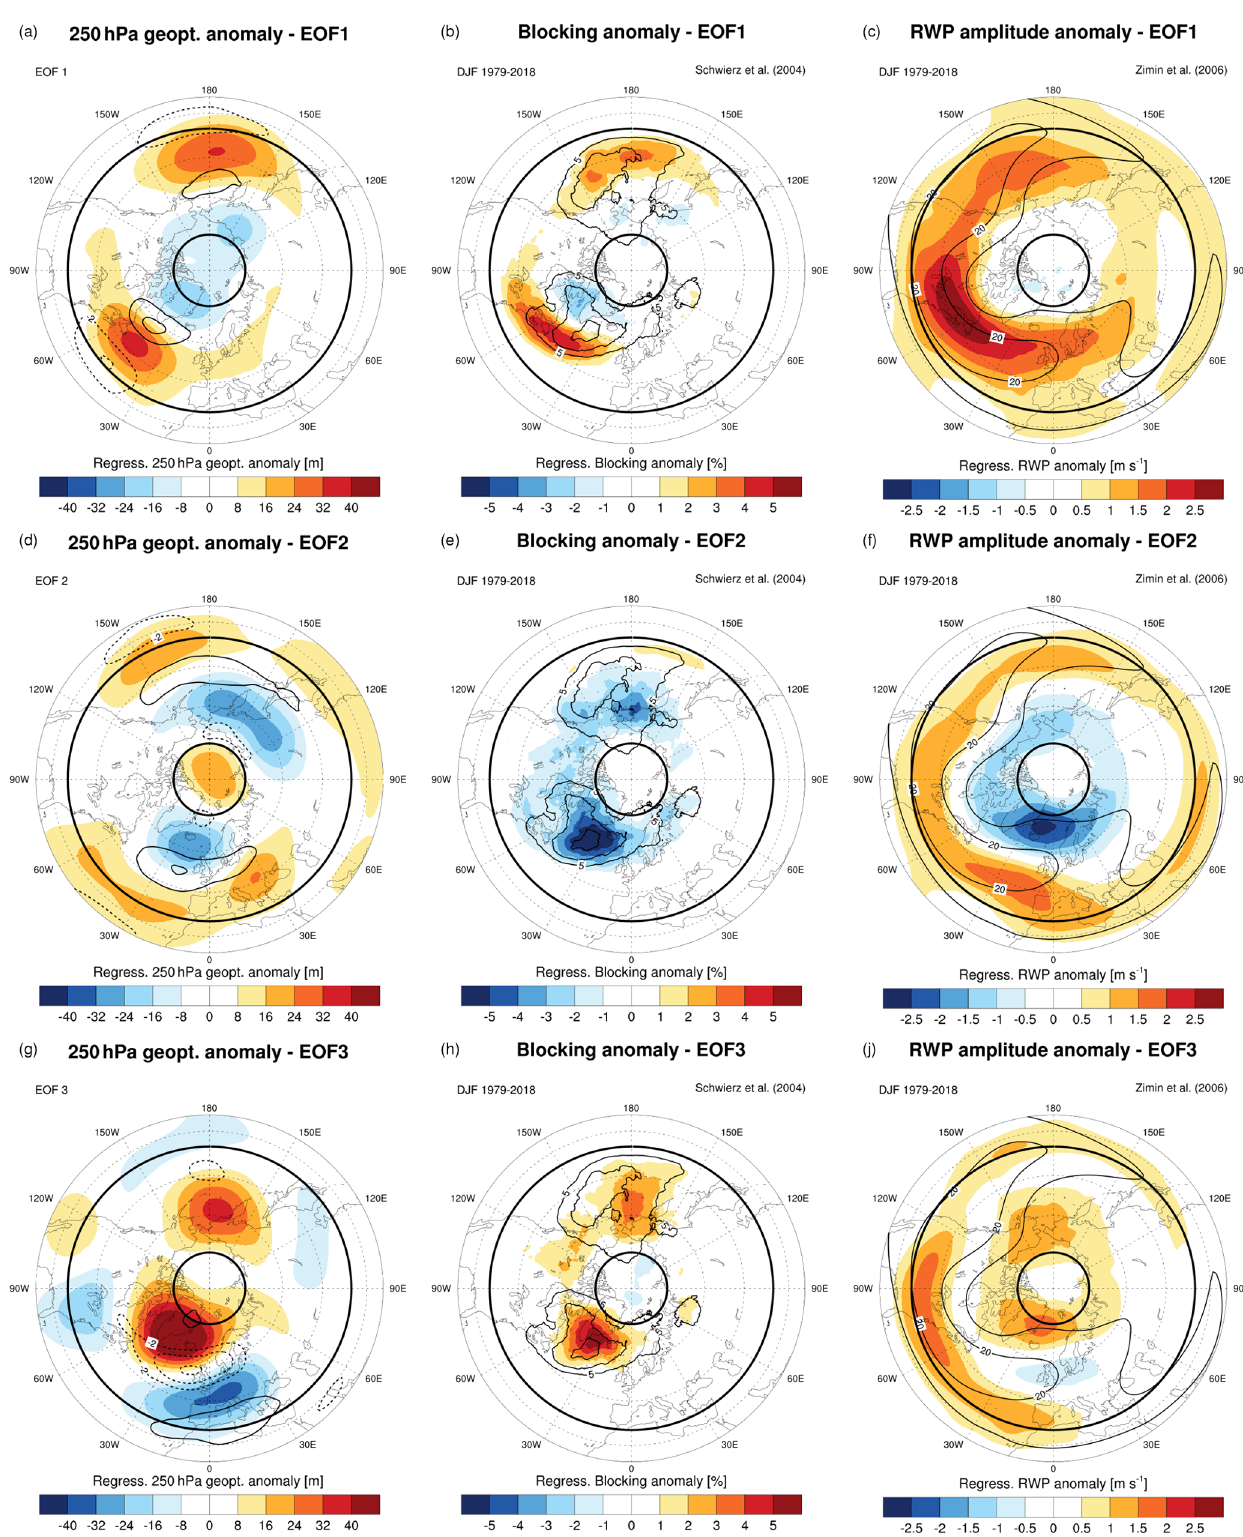
Figure 3. Linear regression of anomalies in (a, d, f) 250hPa geopotential, (b, e, h) blocking frequency and (c, f, j) RWP amplitude with respect to the daily PC time series of (a–c) EOF1, (d–f) EOF2 and (g–i) EOF3. The regressed 250hPa zonal wind anomalies and the DJF climatologies of blocking and RWP amplitude are overlaid over the respective plots (black contours). Bold black latitude circles indicate 35 and 75 ◦